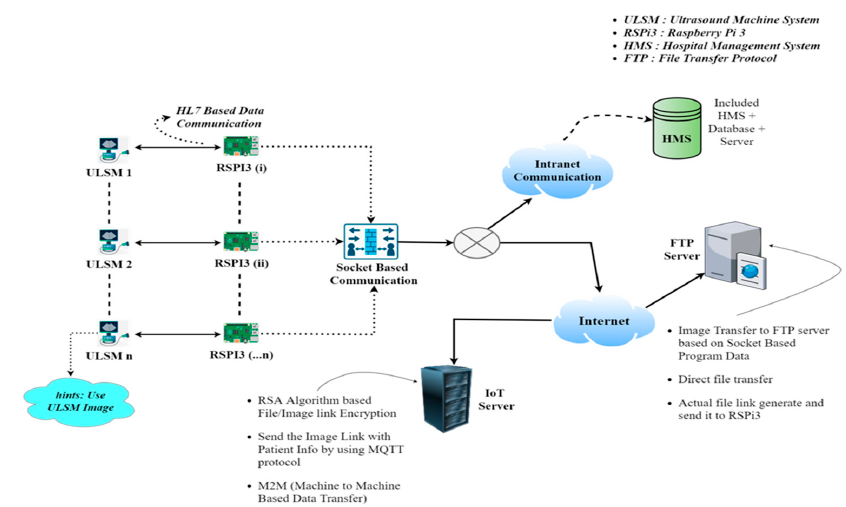
Figure 2. Schematic diagram (full system).